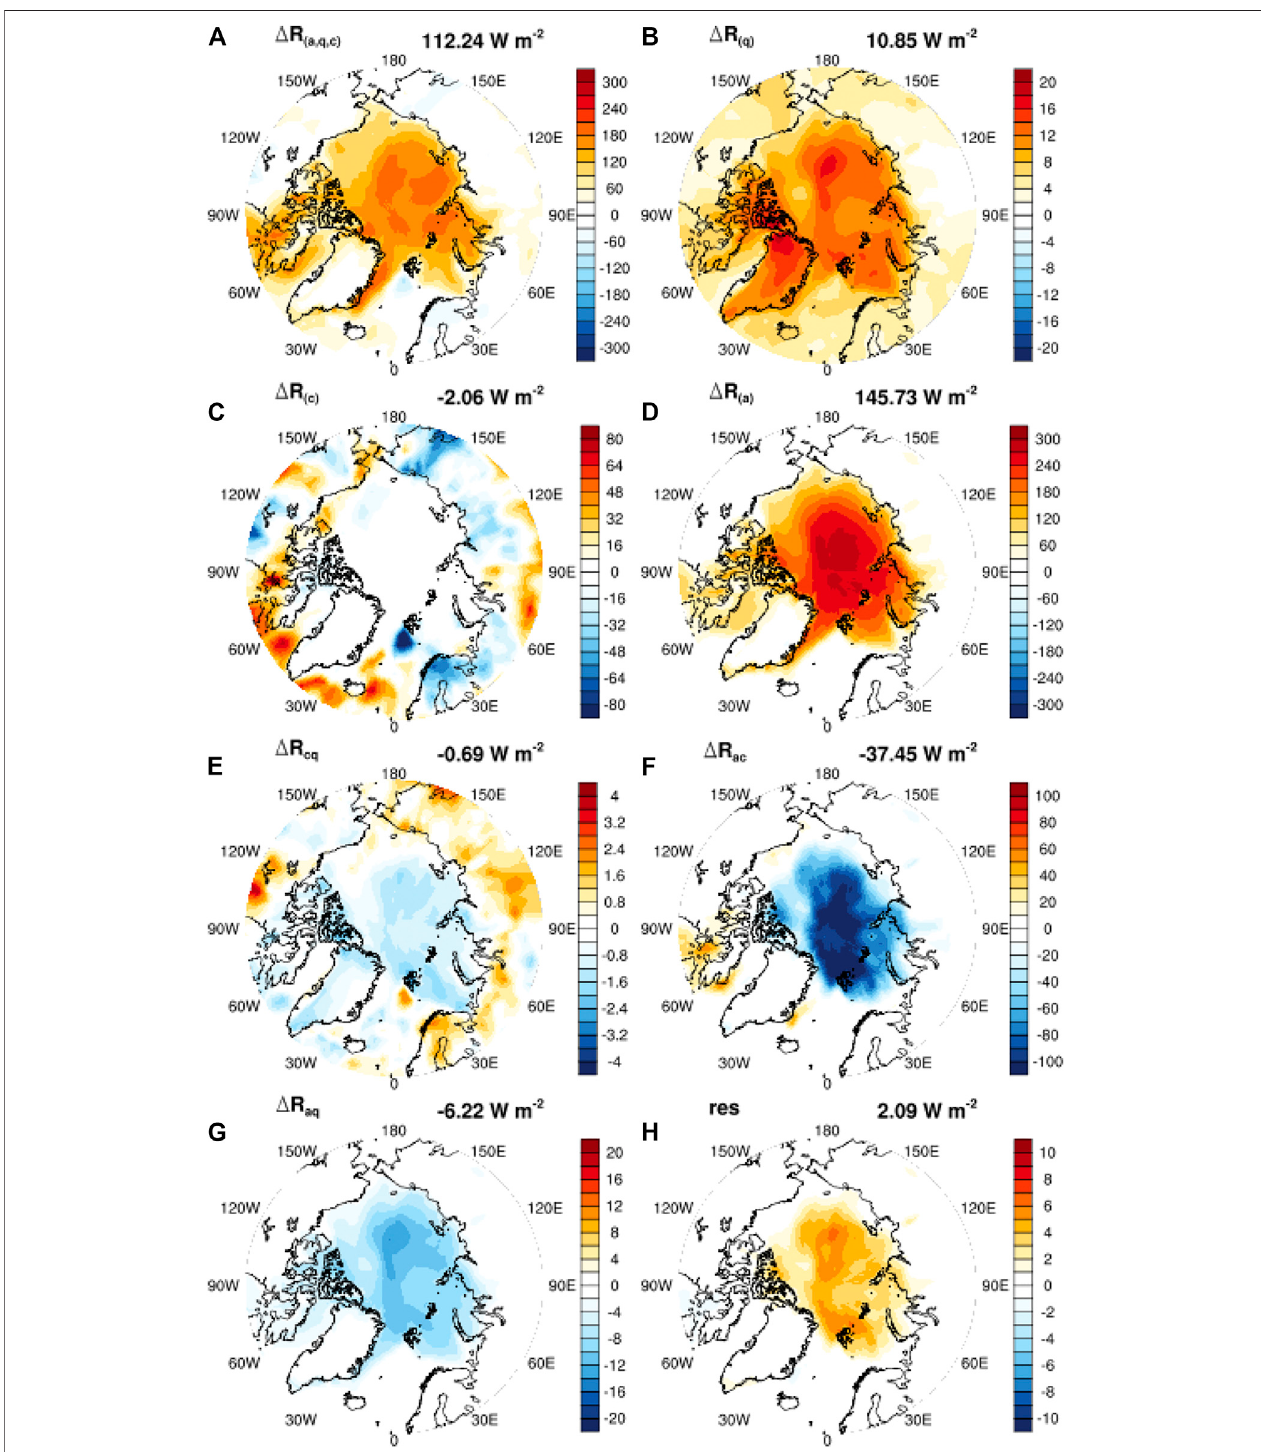
FIGURE 8 | Like Figure 7 , but for the all-sky SW feedback effects in June. Units: W m − 2 .